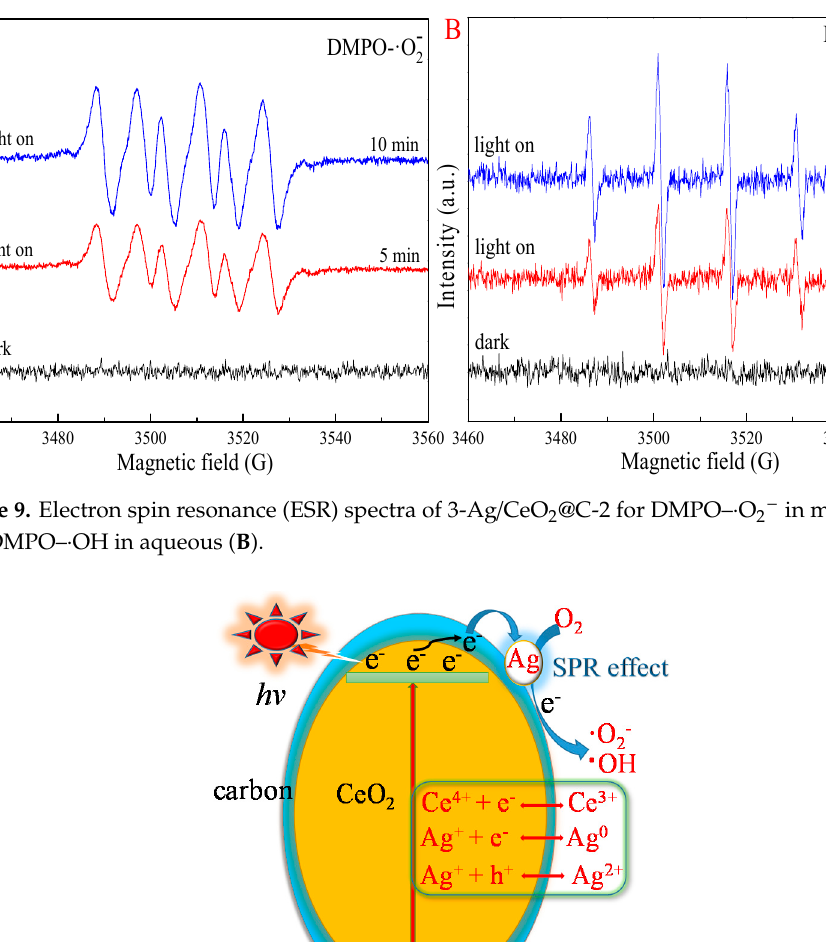
/ CeO 2 @C-2 in Cr(VI) removal in the visible-light region.